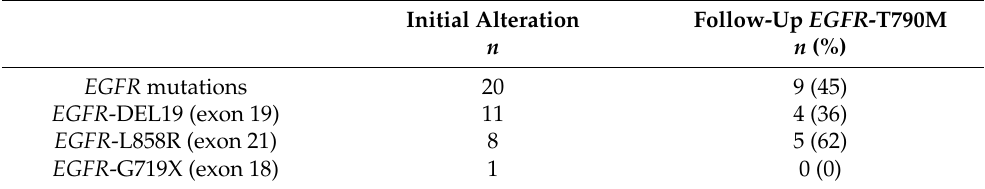
Table 4. Lung adenocarcinoma patients under investigation for genomic mutations identified with ctDNA liquid biopsy and detection of EGFR-T790M during follow-up care. Initial Alteration